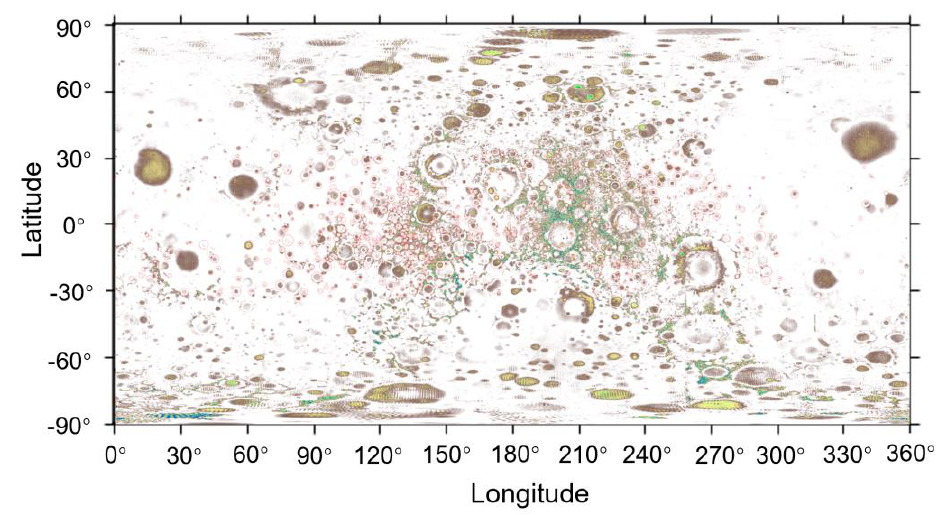
Figure 12. The identification results of the impact craters from gravity anomaly map by U-net.